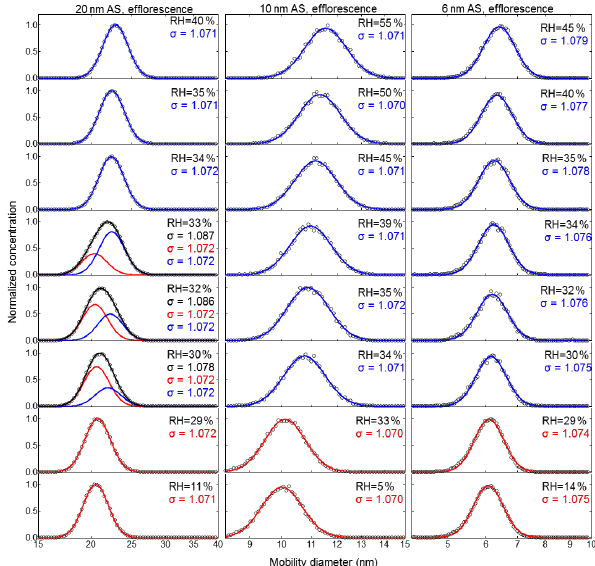
Figure 6. Efflorescence-mode measurements of ammonium sulfate (AS) aerosol nanoparticles with a dry mobility diameter from 20– 6nm. The measured (black circles) and fitted (solid lines) normal- ized size distribution are shown for increasing RH. The red and blue lines represent the aerosol nanoparticles in the solid and liq- uid state, respectively. The RH history in each measurement is 5% → 97% → X %, where X is the RH value given in each